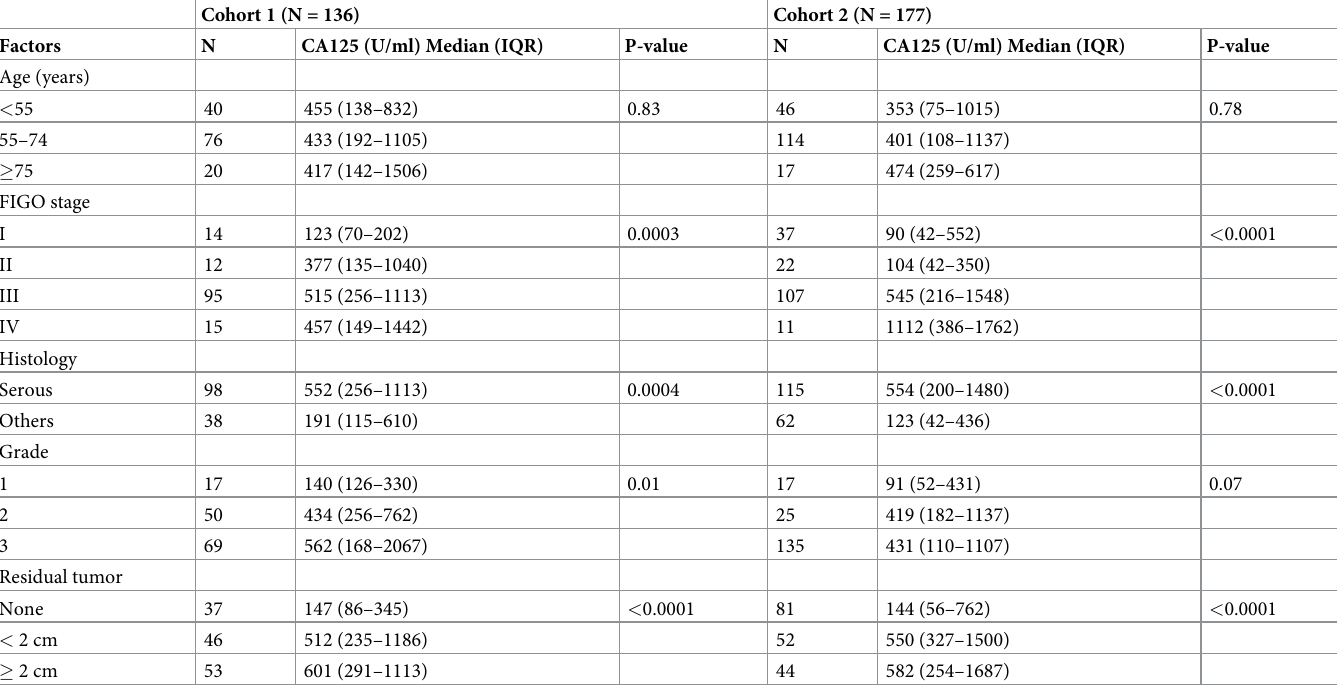
Table 3. Preoperative plasma CA125 levels according to standard prognostic factors in women with epithelial ovarian cancer.